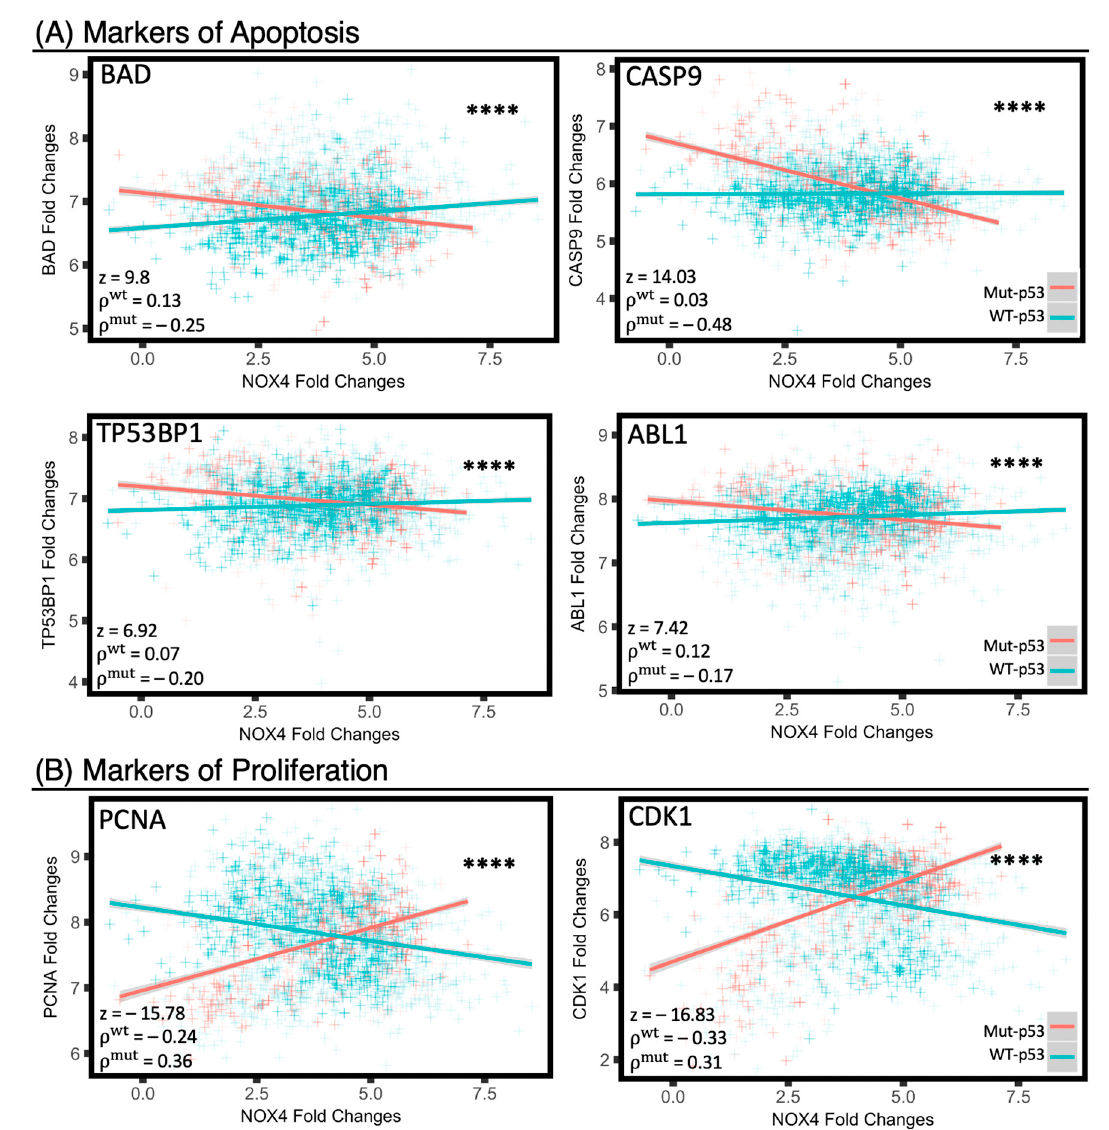
Figure 8. Mut-p53 and WT-p53 divergently affect NOX4 correlations with cell proliferation and apoptosis markers. From the Preliminary Pan-Cancer Dataset, samples were identified as either harboring WT- TP53 or Mut- TP53 . Scatterplots were generated to visualize relationships between NOX4 and canonical markers of cell apoptosis ( A ) and cell proliferation ( B ). Spearman’s rank correlation coefficients were calculated and compared between WT and Mut- TP53 group using two-tail Fisher’s r-to-z transformation. n wt = 2368, n mut = 888. **** p -value < 1 × 10 − 5 . Genes associated with apoptosis or proliferation and their corresponding functions are provided in Table